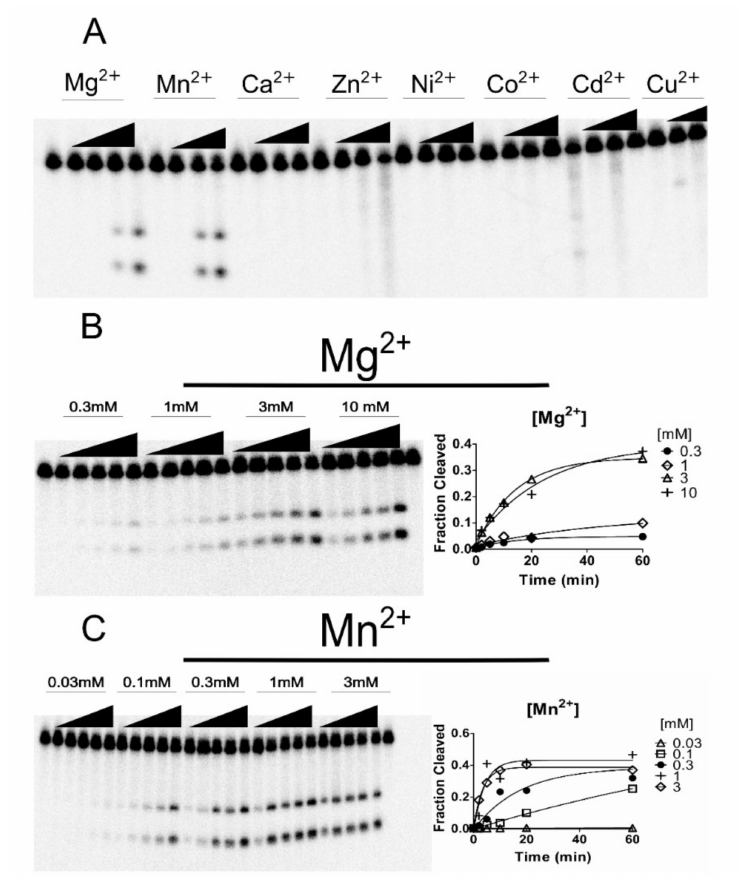
Figure 2. Cleavage assay for the hammerhead ribozyme Bcep176 (C6). ( A ) Cleavage assay of Bcep176 (C6) in the presence of other metals. For Mg 2 + , concentrations of 0, 0.01, 0.1, 1 and 10 mM were used. For the other metal ions tested, the concentrations were 0, 0.01, 0.1 and 1 mM. For assays with Cu 2 + , the concentrations were 0, 0.01 and 0.1 mM. ( B , C ) Cleavage assay of HHRz Bcep176 (C6) in the presence of indicated concentrations of Mg 2 + and Mn 2 + . Incubation times were 2, 5, 10, 20 and 60 min at 37 ◦ C. The first and last lanes are negative controls (no divalent